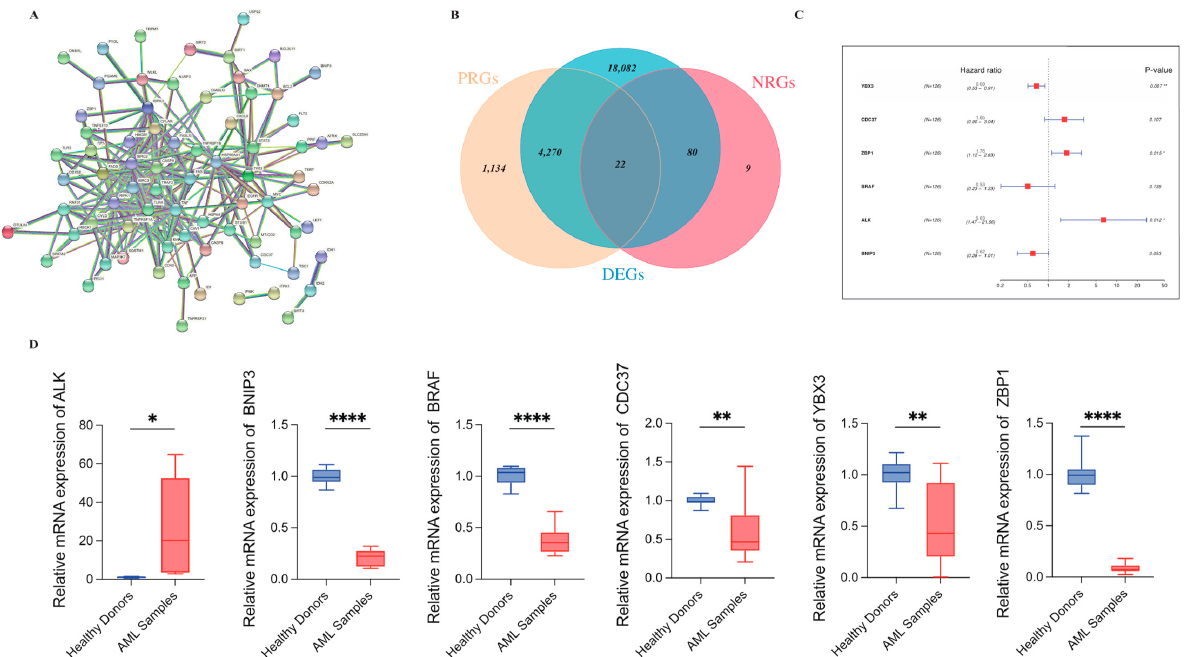
Figure 2. Filtering of differentially expressed necroptosis-related genes of prognostic value. ( A ) Molecular interactions of 111 necroptosis-related regulators depicted by the STRING platform. ( B ) Venn plot shows integration of 3 groups of genes and the overlapping part consists of 22 genes. ( C ) 6 genes were eventually screened through the multivariate Cox regression to generate the prognostic model.